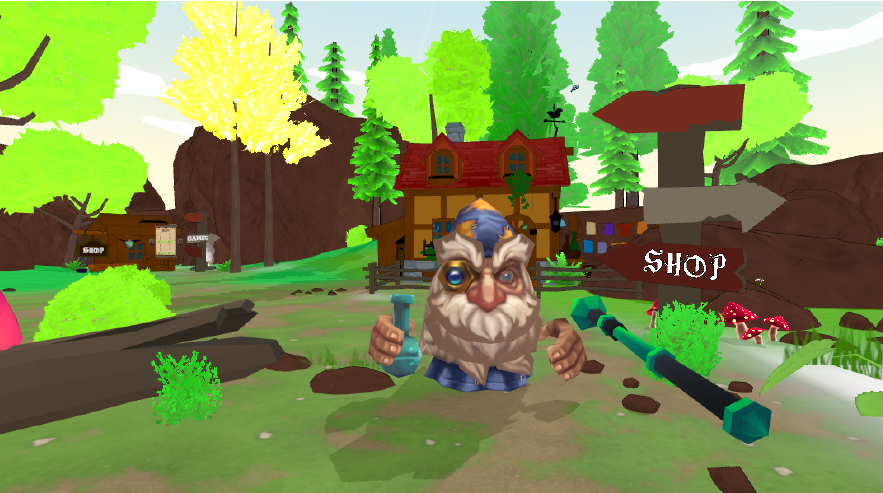
Figure 1. Nonplayable character Fabian.